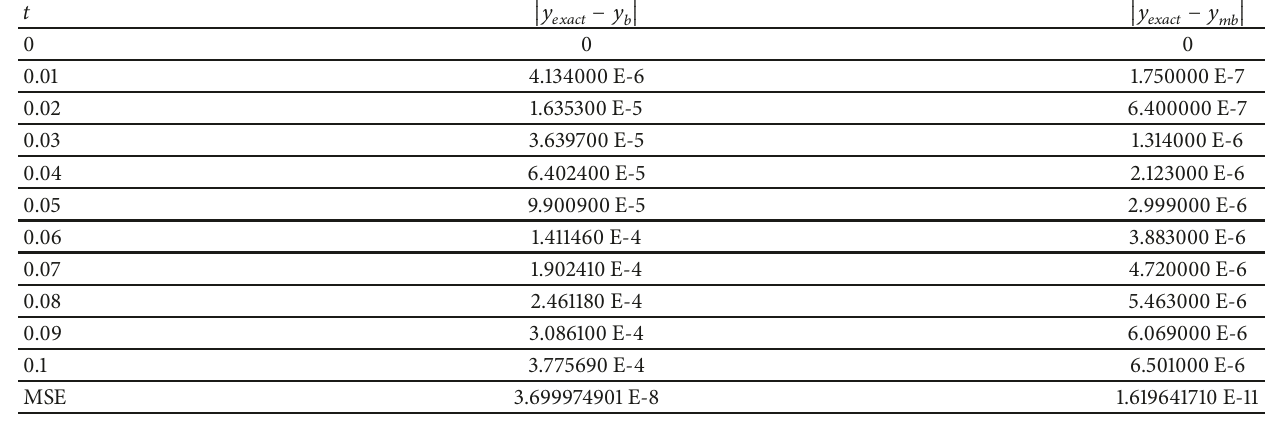
Table 3: Comparison of absolute errors using 𝑦 10 when m=12, v=8, and k=3.